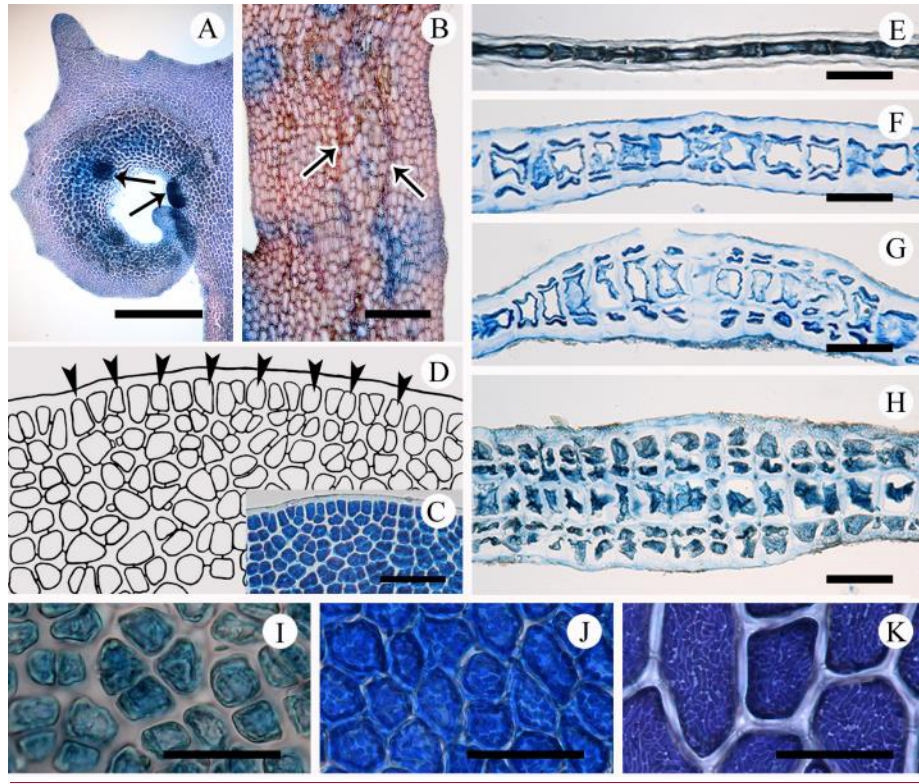
Figure 4. Vegetative structures of Acrosorium flabellatum Yamada. ( A ) Terminal hook with multi- cellular peg-like rhizoids (arrows). ( B ) Surface view of middle part of thallus with microscopic veins (arrows). ( C , D ) Apex of young thallus showing numerous obliquely dividing apical cells (arrowheads). ( E – H ) Cross-sections of blade through upper ( E ), middle ( F ), stipe ( G ), and basal ( H ) portions of blade. ( I – K ) Polygonal cortical cells with parietal chloroplasts from near meristematic ( I ), middle ( J ) and lower ( K ) parts of blade. Scale bars: ( A ), 1 mm; ( B ), 300 µm; ( E – H ), 100 µm; ( C , J , K ), 50 µm; ( I ), 30 µm.